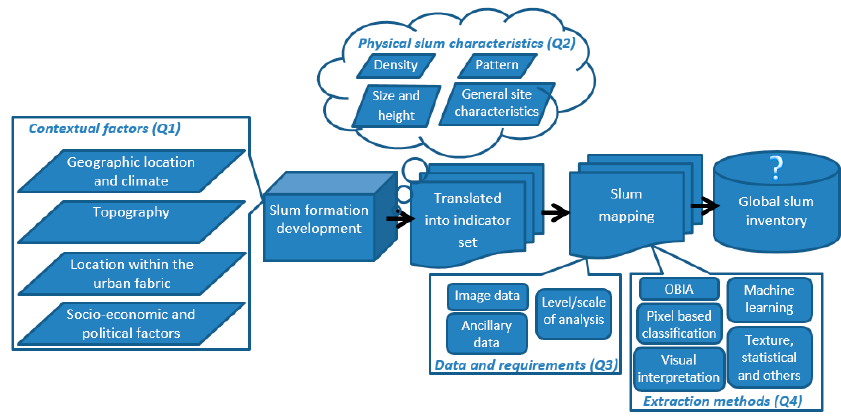
Figure 2. Analytical frame of the review: methodological challenge for a global slum inventory.